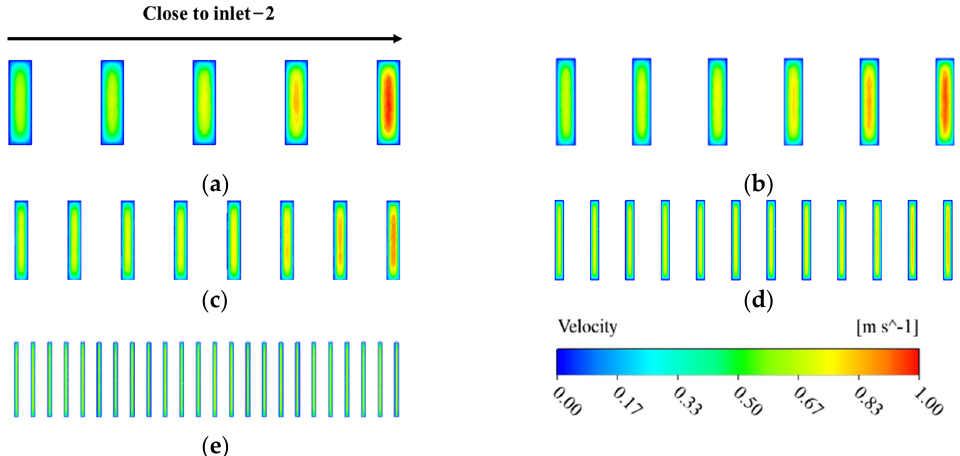
Figure 13. The velocity distribution of the channel section of the flow field − 2. ( a ) N = 10; ( b ) N = 12; ( c ) N = 16; ( d ) N = 24; ( e ) N = 48.